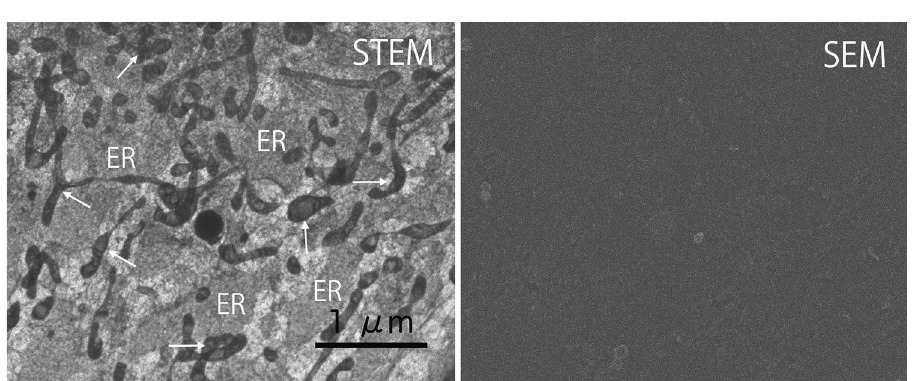
Figure 7. Simultaneous STEM images and SEM image showing a micro-unroofed cell with many organelles. A micro-unroofed cell was similar to a normal cell in appearance, but a very small area of the cell membrane was removed, or very tiny holes were opened. The SEM image did not appear even after ice sublimation more than 1 h because the apical membrane covered most areas of the cell. STEM revealed the spatial architecture of several organelles and filaments, as in high-resolution light microscopy. A large endoplasmic reticulum (ER) network was observed beneath the cell membrane. Mitochondria were also observed, sometimes branching or overlapping with the